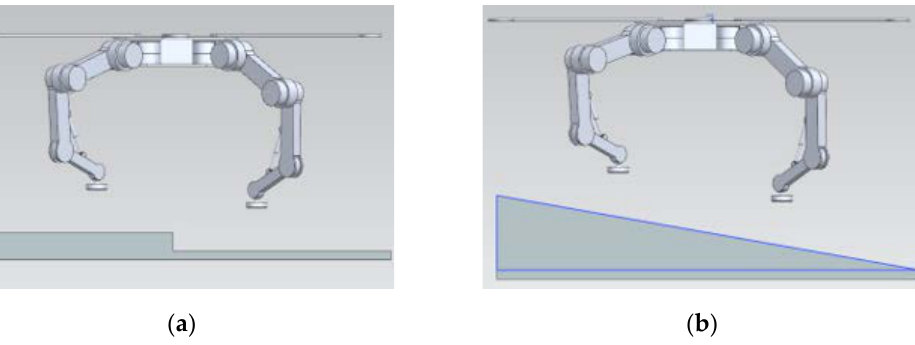
Figure 5. The simplified landing terrains with height difference or slope angle in Simcenter3D: ( a ) represents a drop test ground model with a height difference of 0.05 m; ( b ) represents a drop test ground model with a slope angle of 10°.